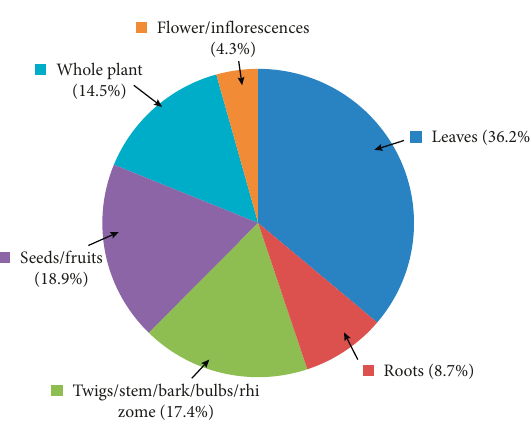
Figure 3: Plant parts used in herbal preparations.